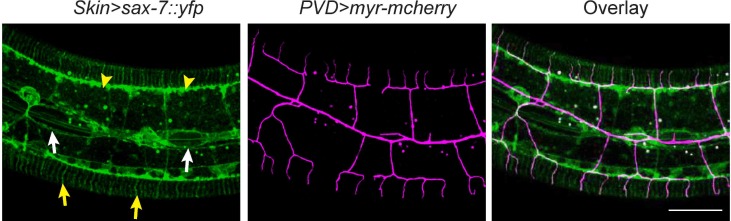
PVD dendrites do not grow along all the SAX-7 positive loci.Confocal images showing the subcellular localization of SAX-7::YFP expressed in the epidermis(left), the morphology of PVD dendritic arbors (middle) and overlay (right). Arrow heads: tertiary line along the border of outer body wall muscles; Yellow arrows: quaternary stripes where quaternary dendrites grow along. White arrows: epidermal-seam cell junctions labeled by SAX-7::YFP. Note that PVD dendrites mainly grow along the SAX-7 signal in the epidermal-muscle interface but rarely grow along the epidermal-seam cell junctions. Scale bar: 20 μm.